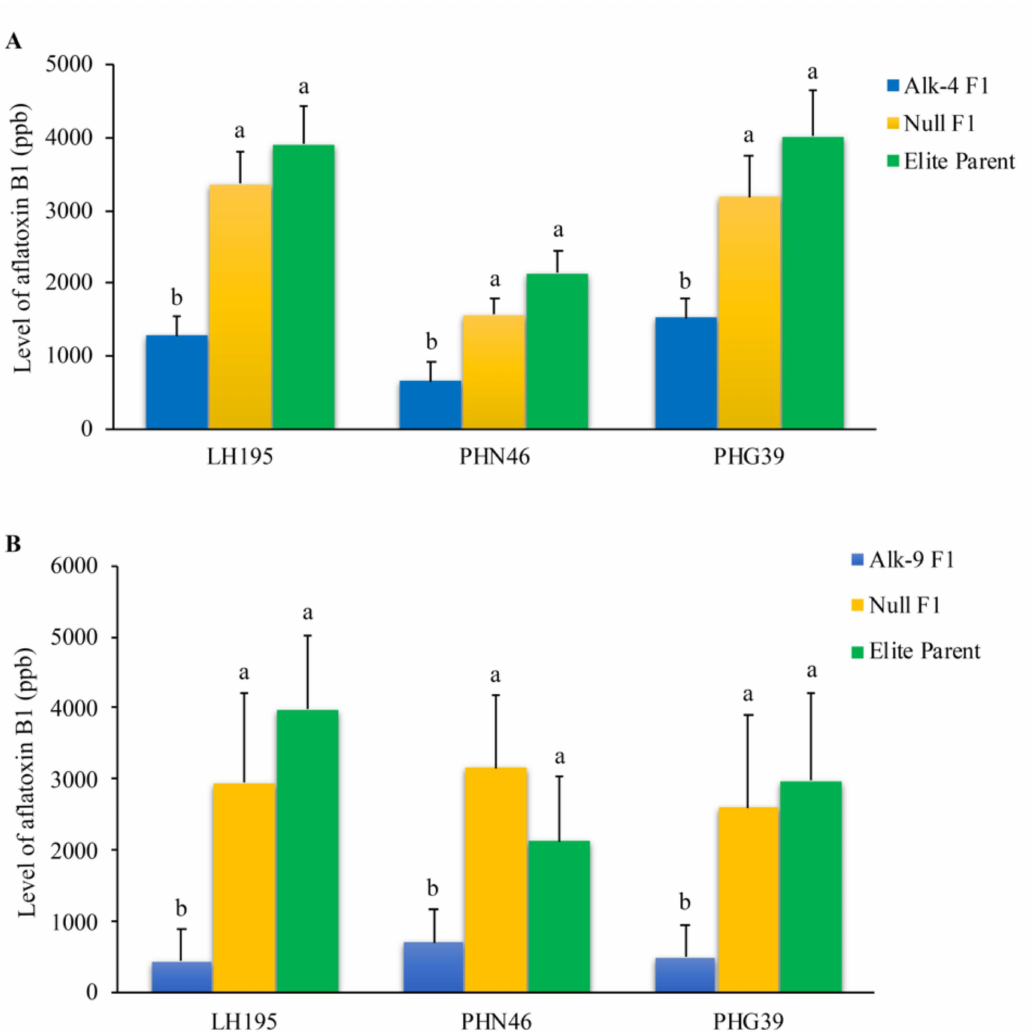
Figure 4. Aflatoxin production in mature kernels of the F1 crosses between Alk-4 ( A ) and Alk-9 ( B ) transgenic and null plants with three elite inbred lines (LH195, PHN46 and PHG39) under field inoculation conditions. Significant differences were observed in aflatoxin accumulation ( p < 0.006 to p < 0.045) of F1 crosses between Alk-4/Alk-9 homozygous transgenic line and elite inbred lines compared with control F1 crosses between Alk-4/Alk-9 null and elite inbred lines as well as self-pollinated elite lines. Inoculum concentration of 1 × 10 5 conidia/mL was used for this experiment. Four different points were inoculated on each ear. Lower half of each ear with the four inoculation points was ground and 3 subsamples per ear were used for aflatoxin extraction. This analysis was carried out using 27–45 sub-samples from 9–15 ears for each